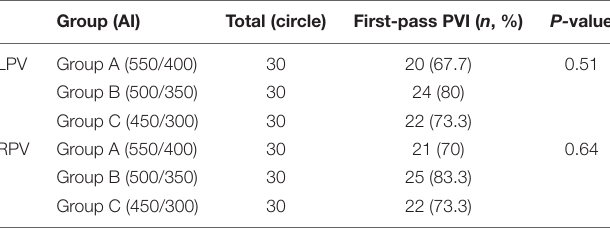
TABLE 2 | Comparison of first-pass PVI among three